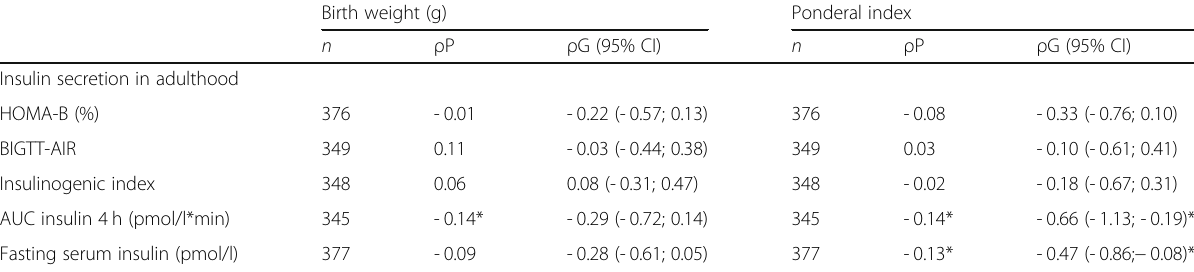
Table 5 Correlations between measures of birth body composition and adult measures of insulin secretion Birth weight (g)